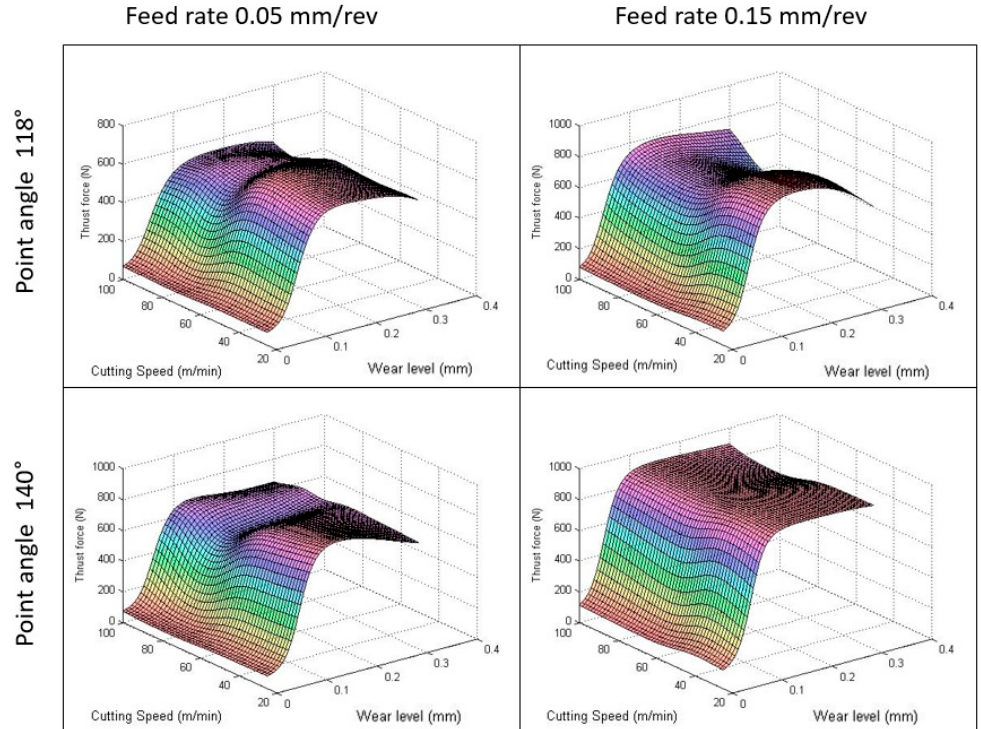
Figure 10. Interaction effects of cutting speed and wear level on the thrust force.